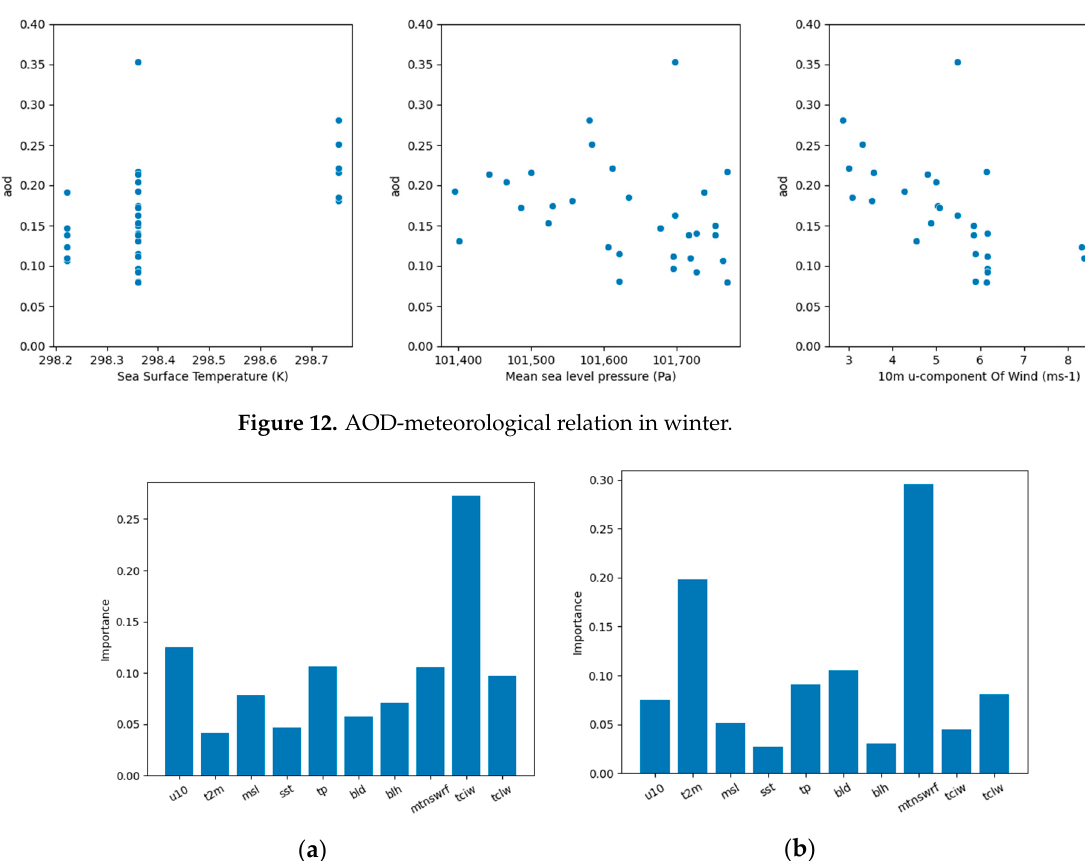
Figure 11. AOD-meteorological relation in fall.